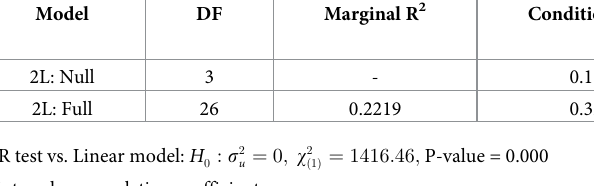
normal probability (p-p) plots are used for this purpose. Diagnostic plots of the level 1 and 2 residuals obtained from the fitted BHF model are shown in Fig 1. The plots in Fig 1 indicate that these distribution features hold for both level 1 and 2 residuals when fitted to HIES 2010 data. We also observed that the household as well as the district level residuals are randomly distributed, and that their line of best fit does not significantly differ from the line y = 0 in both